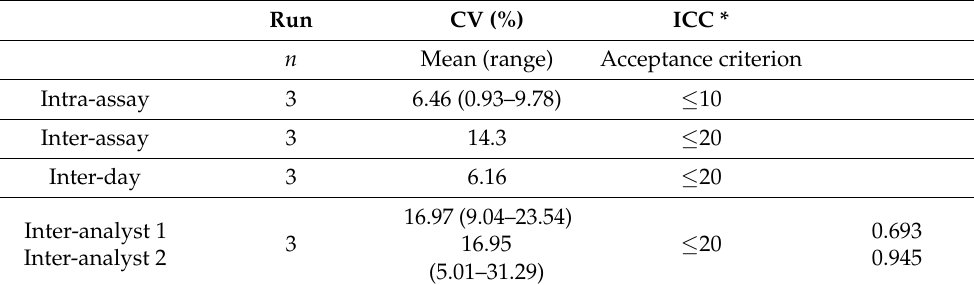
Table 2. Evaluation of repeatability and intermediate